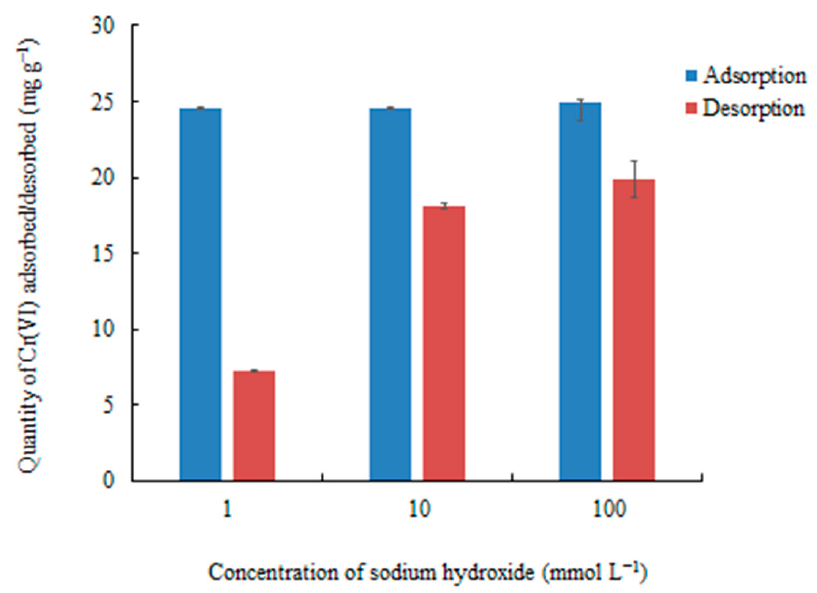
Figure 7. Adsorption/Desorption capability of Cr(VI) using NAZ1.